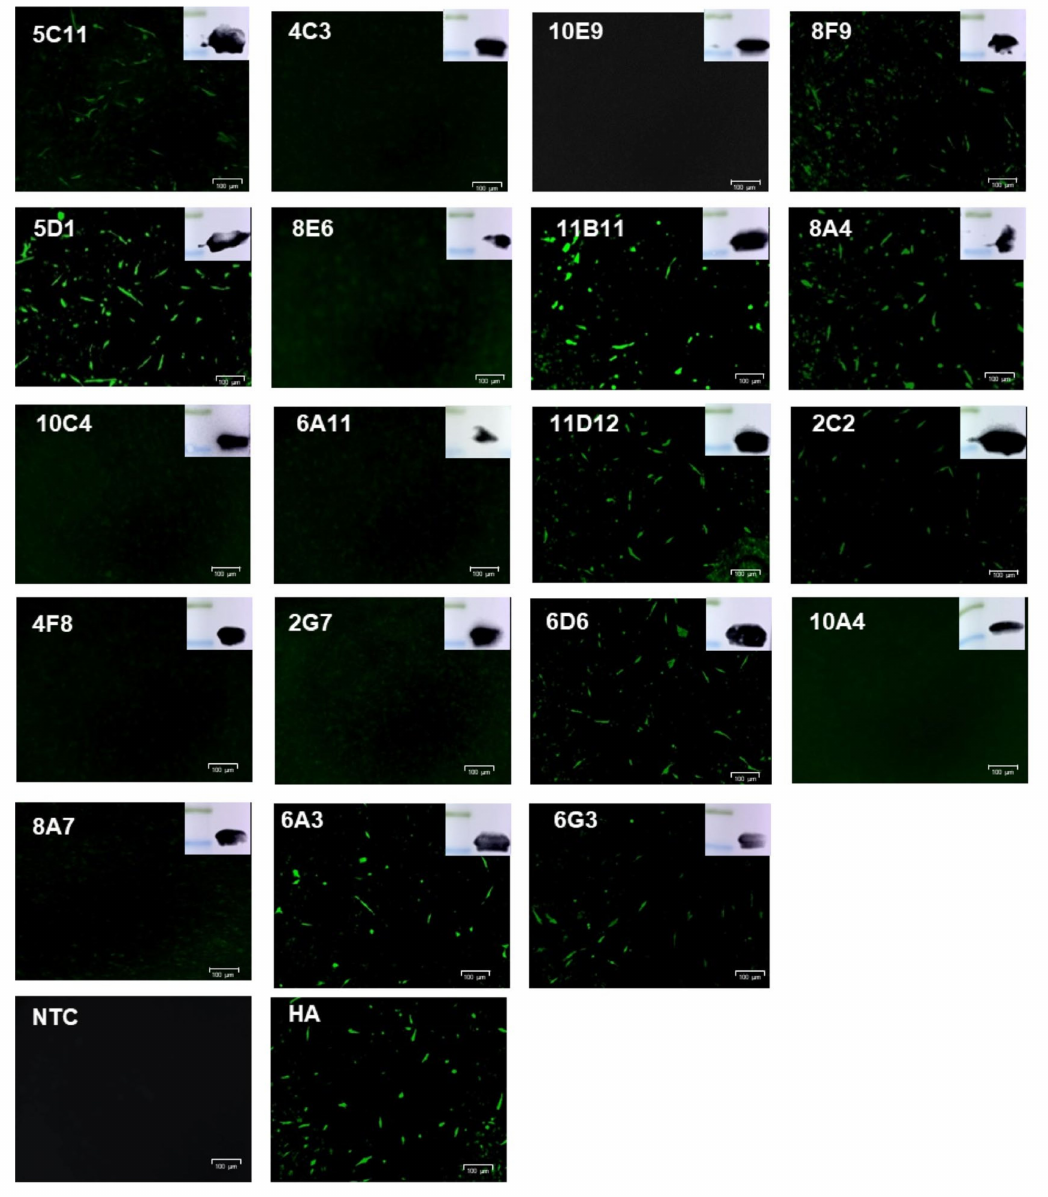
Figure 2. Western blotting analysis of recombinant His-E165R by Anti-E165R-mAbs and immunofluorescence detection of HA-E165R expression in PK15 cells by